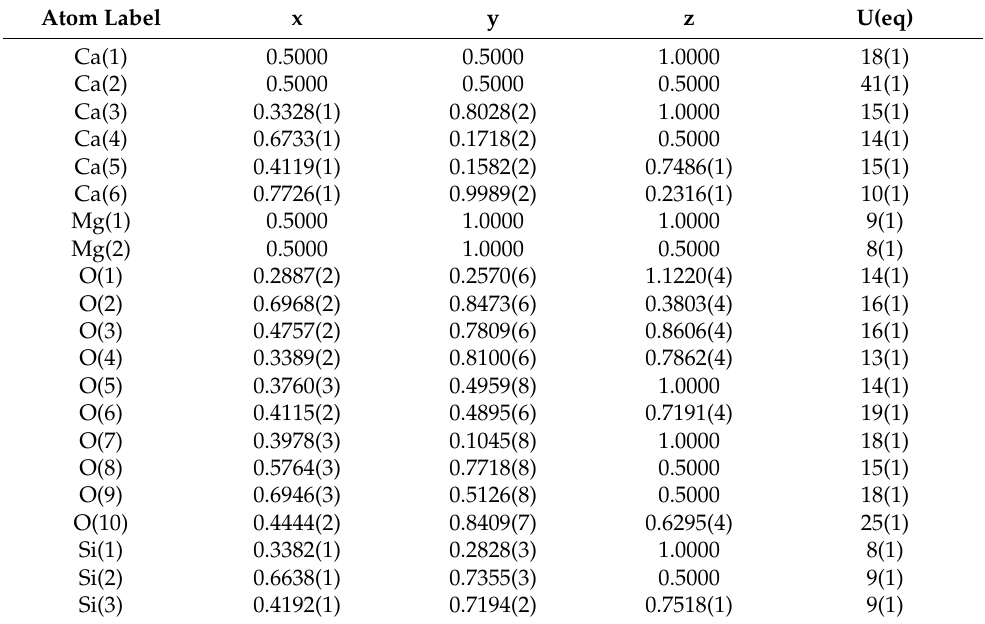
Table 2. Atomic coordinates (x, y, z) and equivalent isotropic displacement parameters (U(eq)) for Ca 7 MgSi 4 O 16 -Bre ( Pnnm